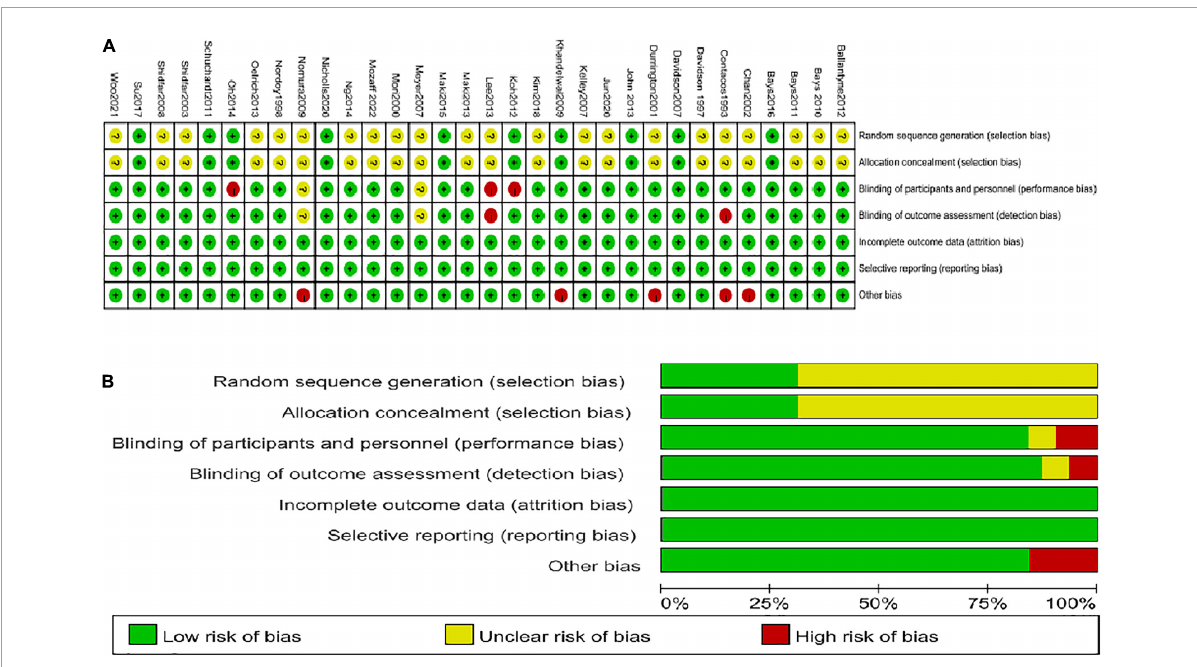
FIGURE2 Summary of quality evaluation based on the Cochrane’s Risk of Bias Tool. (A) Risk of bias summary for each risk of bias item for each included study; (B) Risk of bias graph for each risk of bias item presented as percentages across all included studies.